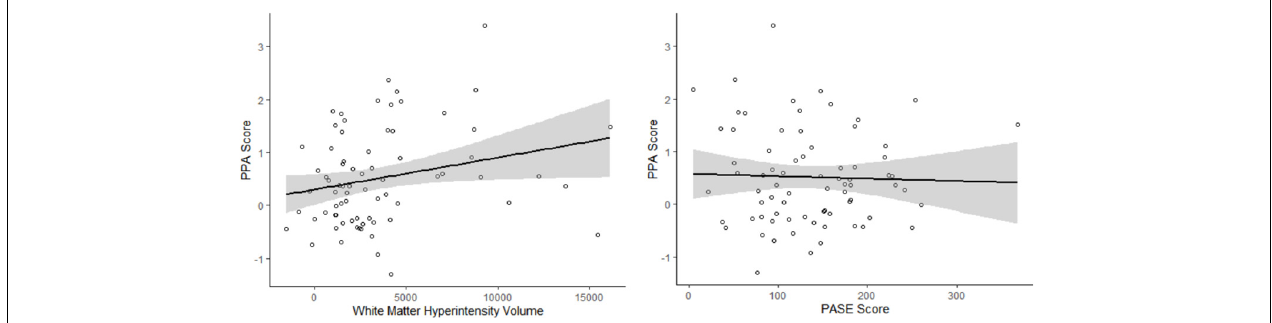
FIGURE 1 | The independent associations of white matter hyperintensity (WMH) volume and Physical Activity Score for the Elderly (PASE) with Physiological Profile Assessment (PPA) score. WMH volume was associated with greater falls risk, independent of PASE score (Adjusted R 2 = 5.3%). Higher PASE score was associated with lower falls risk, independent of WMH volume (Adjusted R 2 = 6.9%). Age, sex, and MoCA score were included as covariates of no interest.